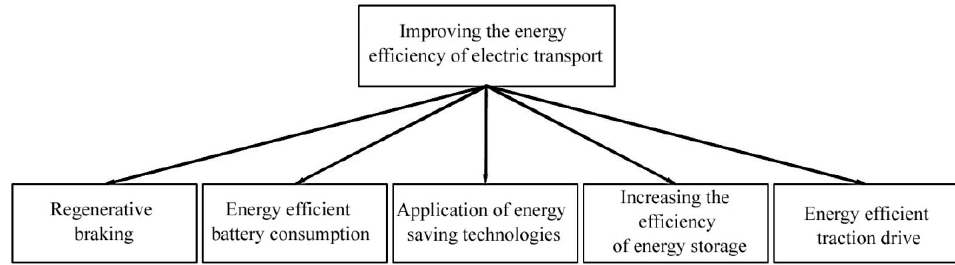
Figure 1. Schematic grouping of the main methods to improve the energy efficiency of the electric